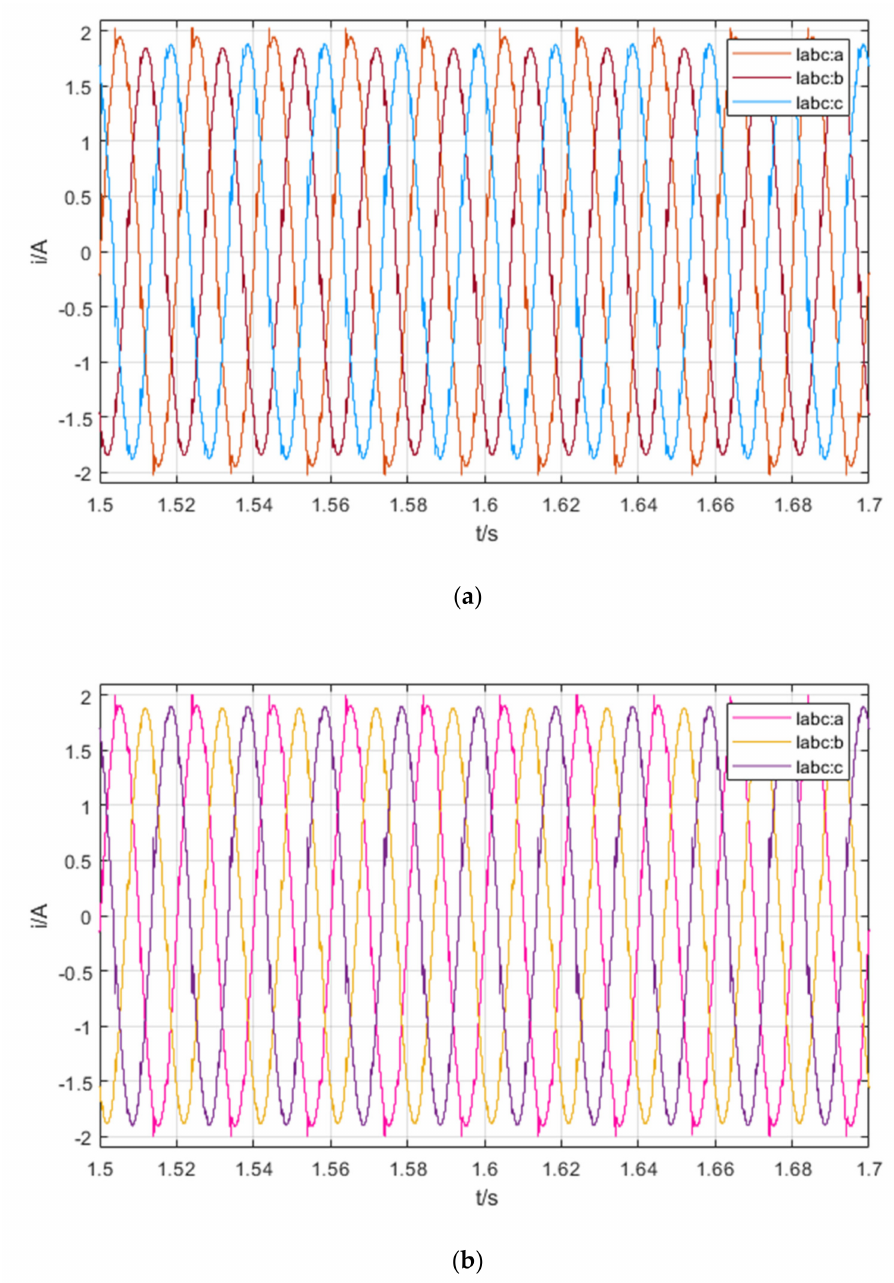
Figure 16. Influence of the harmonic damping control coefficient on the filtering effect under an unbalanced load. ( a ) Dynamic three-phase currents under the proposed HIAF system ( K = 500). ( b ) Dynamic three-phase currents under the proposed HIAF system ( K =